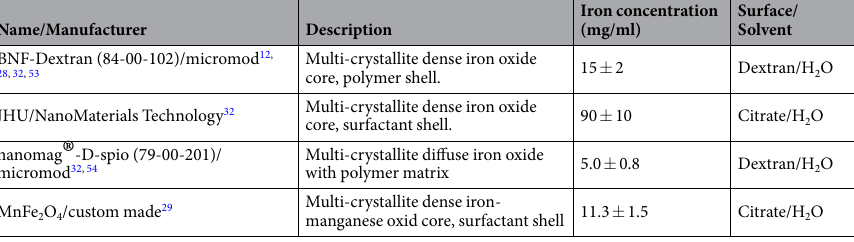
Table 1. Parameters of studied